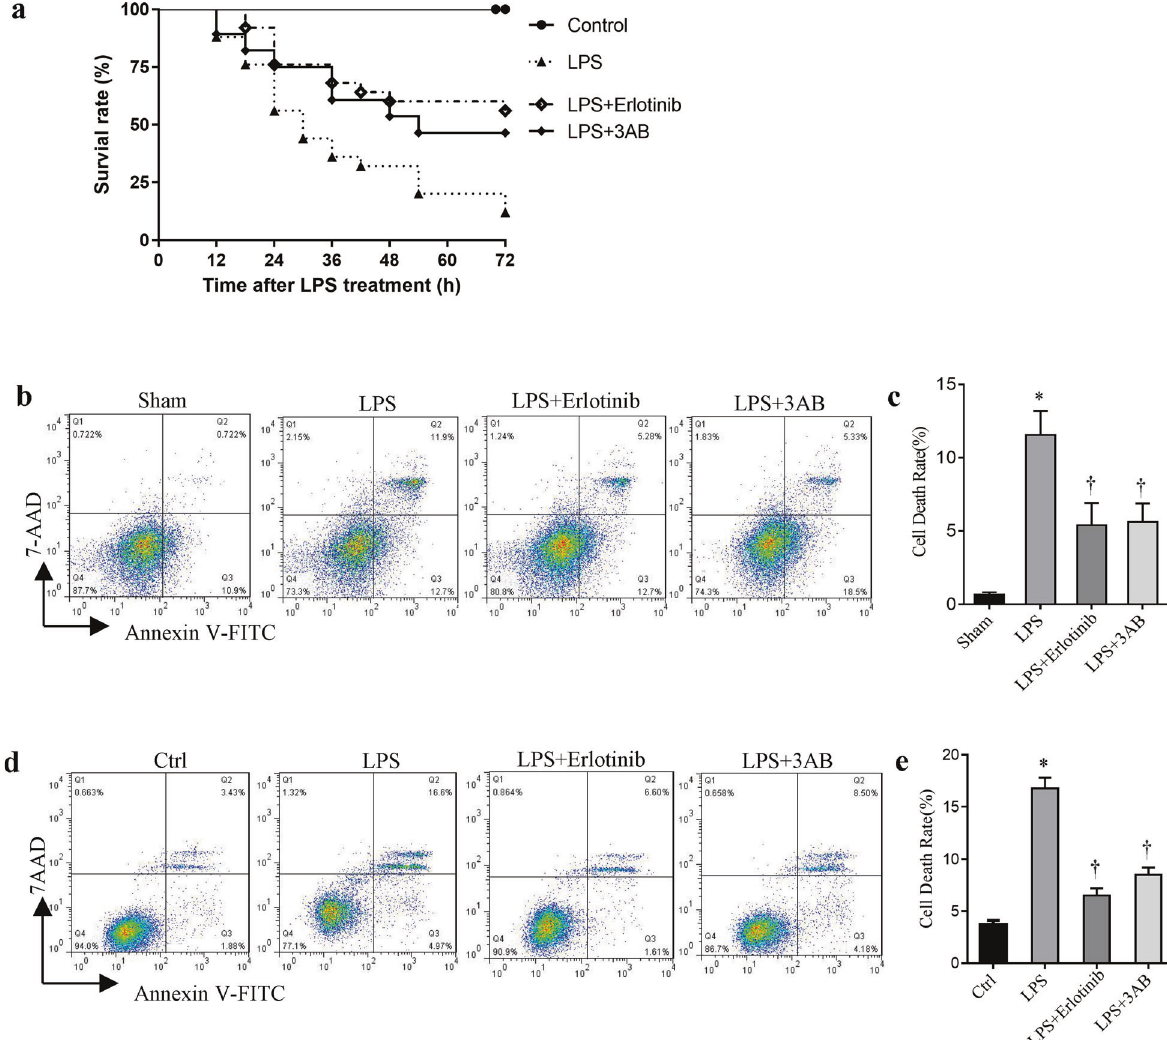
Fig. 1 Effects of erlotinib and 3-AB on mice or cells treated with LPS. Wild-type C57BL/6 mice were primed with 100 mg kg – 1 of erlotinib gavage administration or 3-AB before LPS treatment as described in methods. a After LPS stimulation, survival rate of mice was detected every 6 h for 72 h. LPS + erlotinib group ( n = 20) and LPS + 3-AB group ( n = 20) ’ s life span was signi fi cantly increased compared to LPS group ( n = 20, P < 0.05). b , c After 24 h LPS treatment, peritoneal macrophages were collected and identi fi ed with F4/80. Cell death was analyzed by fl ow cytometry. d , e RAW264.7 cells were treated with LPS for 24 h in the presence or absence of pretreatment of erlotinib or 3-AB for 30 min followed by fl ow cytometry analysis of cell death. Error bars represent SD ( n = 3). * P < 0.05 as compared with Sham; † P < 0.05 as compared with the time-matched LPS